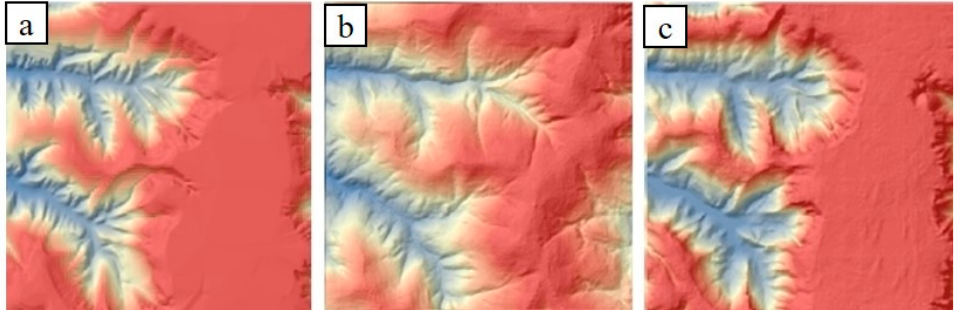
Figure 8. The influence of different terrain features. ( a ) Reference DEM; ( b ) trained by gully and ridge lines; ( c ) trained by gully lines, ridge lines and positive terrain.